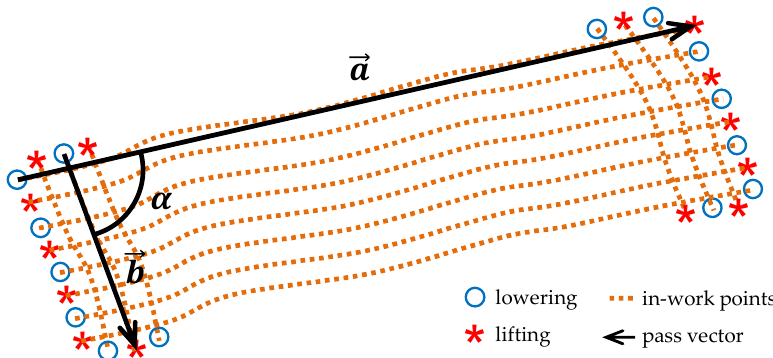
Figure 7. Schematic operating principle of the algorithm for the distinction between main part passes and headland passes.